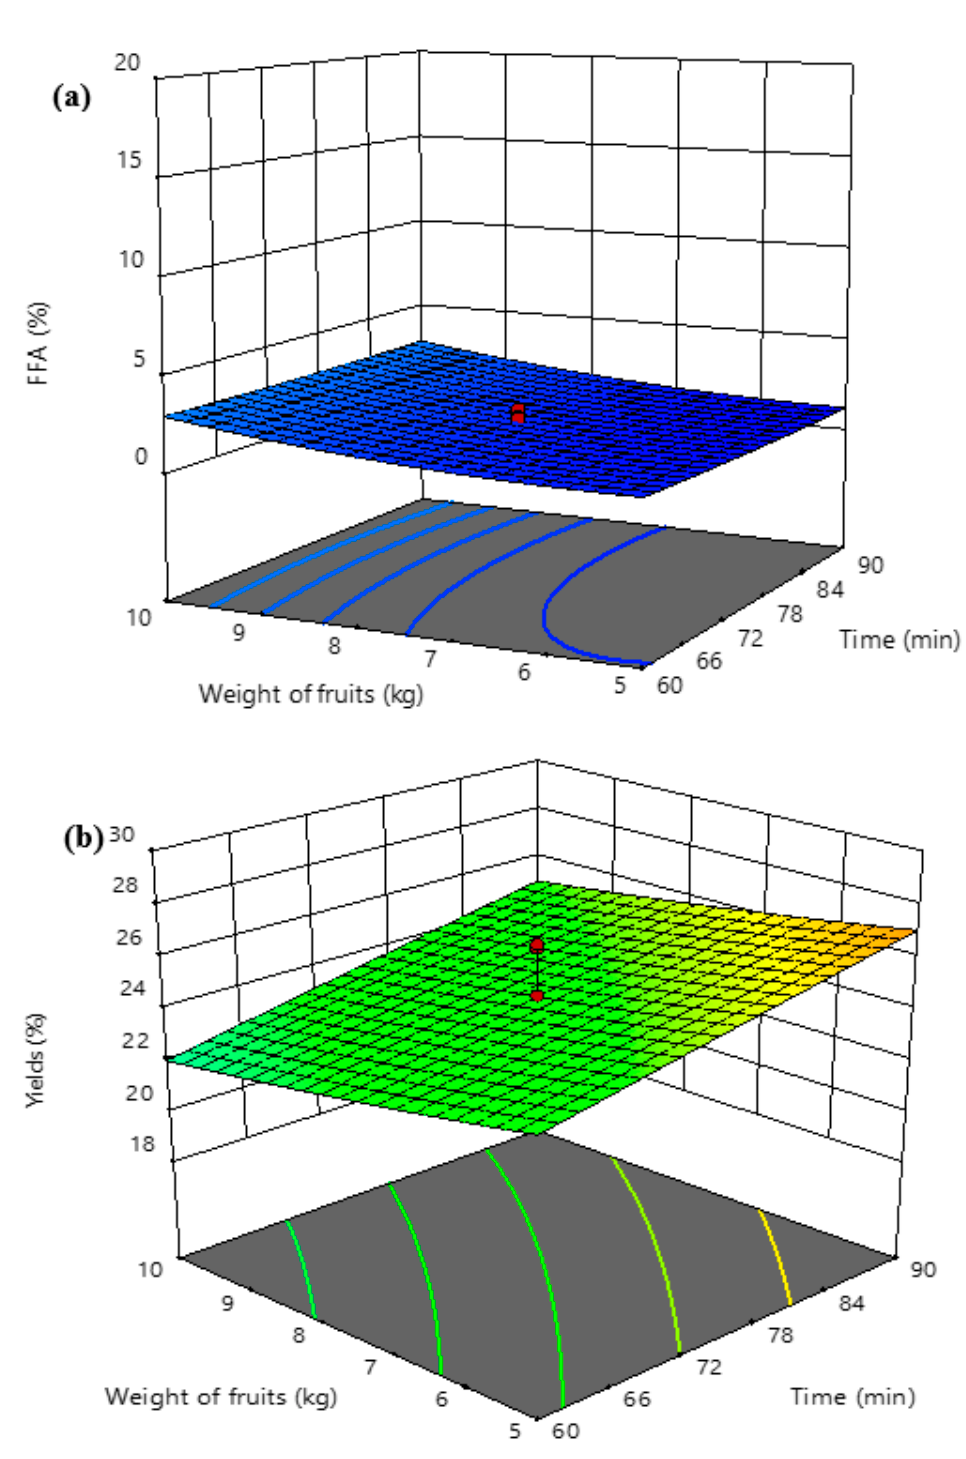
Figure 7. Interaction effects between the cold-pressed sterilization time and weight of fruits on FFAs in cold-pressed VPO ( a ) and VPO yield ( b ).